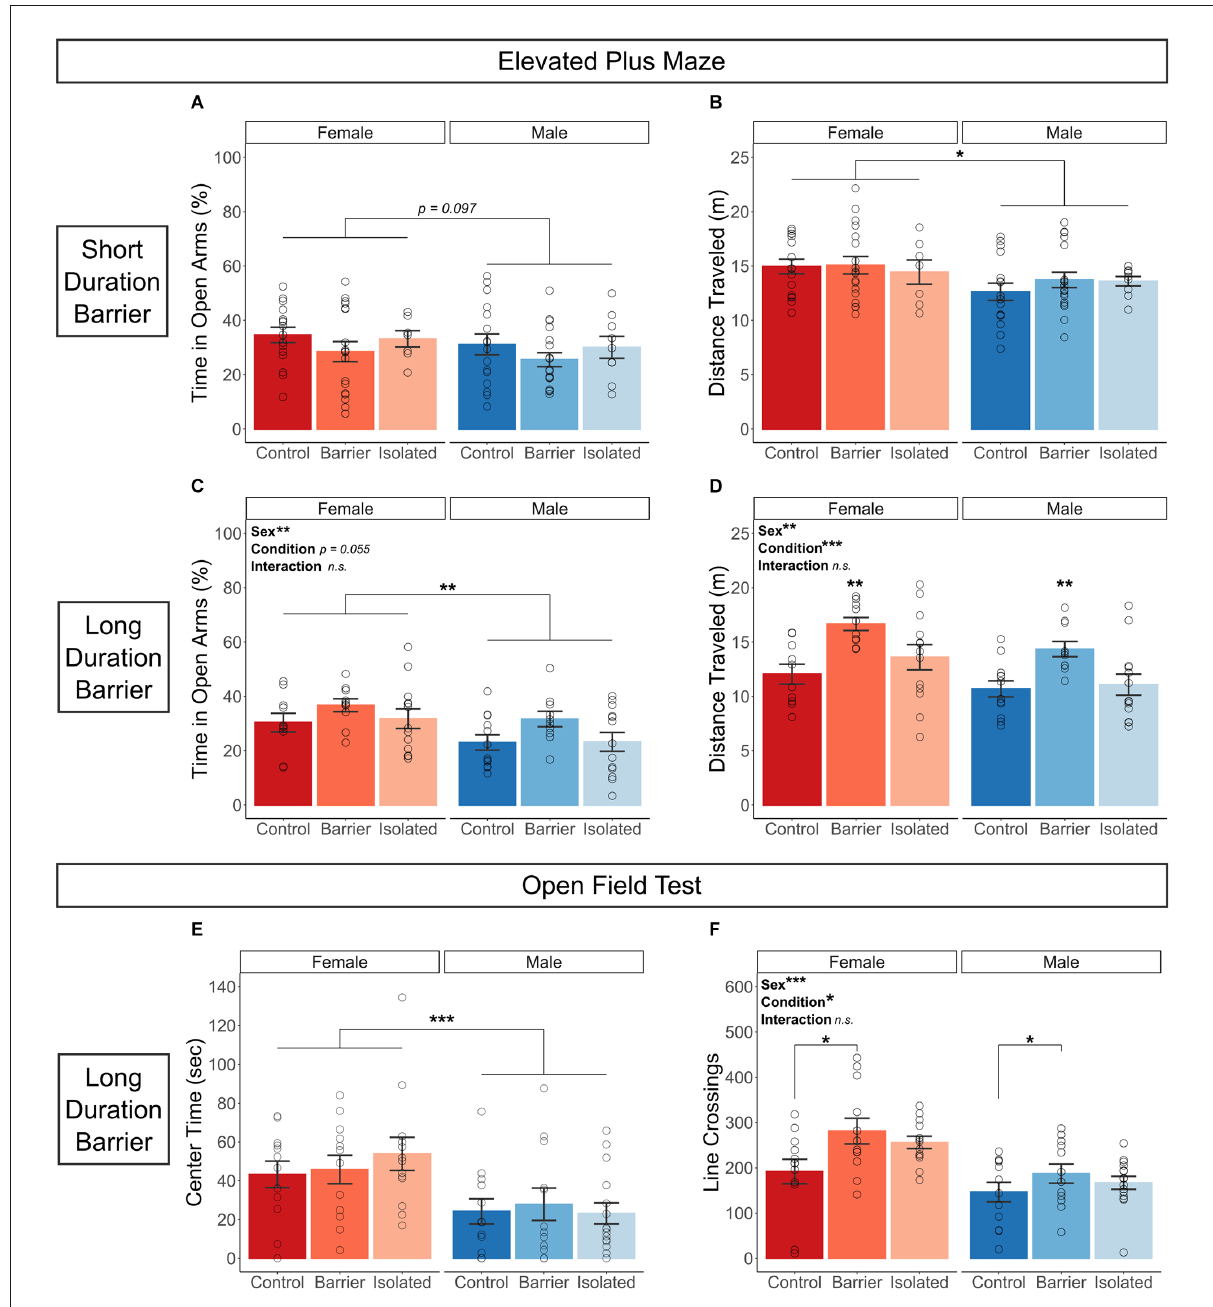
FIGURE2 Juvenile play deprivation induces later-life hyperactivity but has no effect on anxiety-like behavior; however, males exhibit more anxiety like behavior than females. Percentage of time spent in the open arms (A) and distance traveled (B) in an elevated plus maze on P47 in the short duration barrier study, with the same measures shown for the long duration barrier study (C,D) . In (D) , **indicates BARR animals traveled significantly farther than both CTRL and ISO animals, with p < 0.01. An open field test was also conducted at P59 in the long duration barrier experiment, with center time (in seconds) and the number of gridline crossings shown in (E,F) , respectively. In (F) , *indicates CTRL animals exhibited significantly fewer line crossings than BARR animals with p < 0.05. Bars indicate group means ± SEM, and open circles represent data from individual rats. * p < 0.05, ** p < 0.01, *** p < 0.001, n = 10–15 per group.